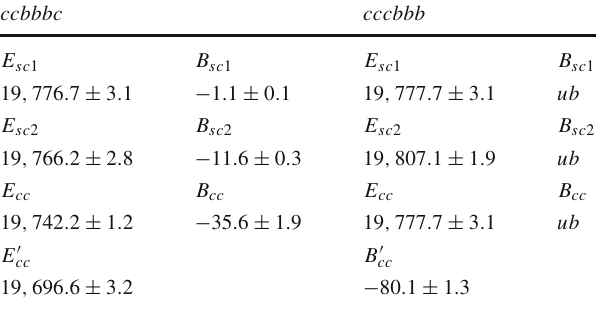
Table 5 The energies and binding energies (in MeV) of every sin- gle channel and the channel-coupling calculation of the Ω ccb Ω bbc and (cid:9) Ω Ω P = 0 + . E (cid:9) ccc bbb systems with J cc and B cc are the results by cou- pling all channels of both Ω ccb Ω bbc and Ω ccc Ω bbb